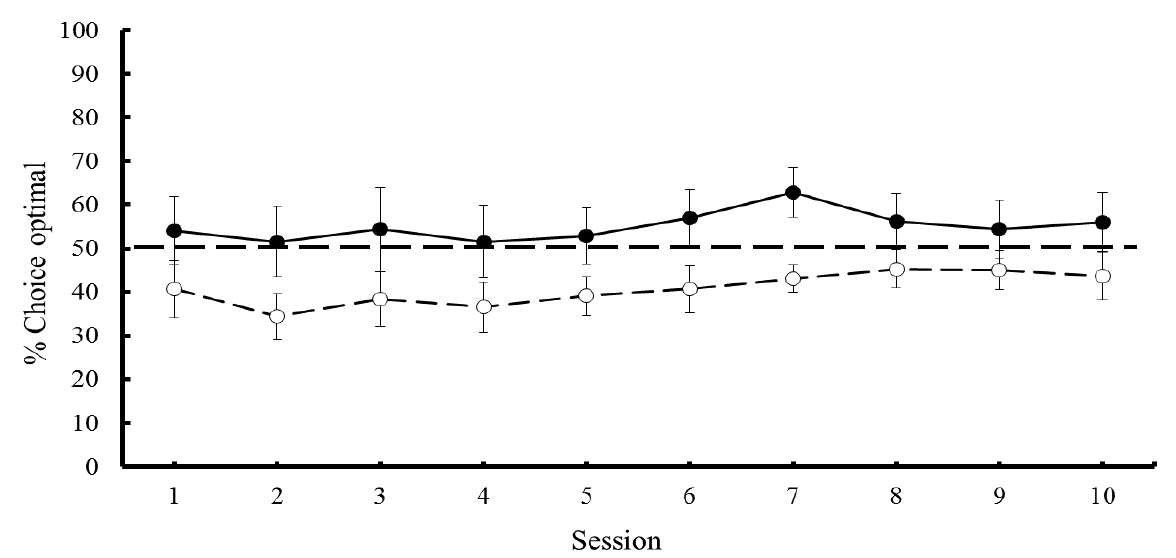
Figure 4 . Pigeons’ performance on the automated (operant) chamber ephemeral reward task. The control group (white circles) is a replication of Zentall et al., (2016, Experiment 2). For the experimental group (black circles) choice of the optimal alternative provided reinforcement and changed the color of the other alternative to white (error bars = ±SEM; after Zentall et al., 2016, Experiment